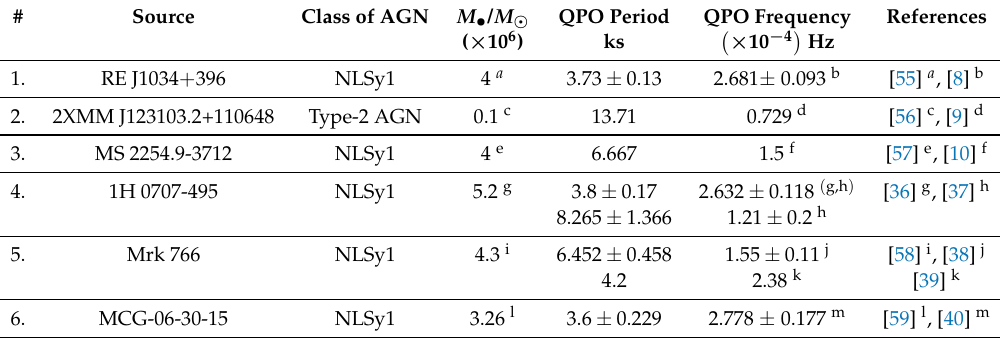
Table 2. A list of statistically significant QPOs detected in the X-ray band (0.3–10 keV) by the XMM-Newton in AGN along with their black masses. The lower-case letters (a to m) provide links to references given in the last